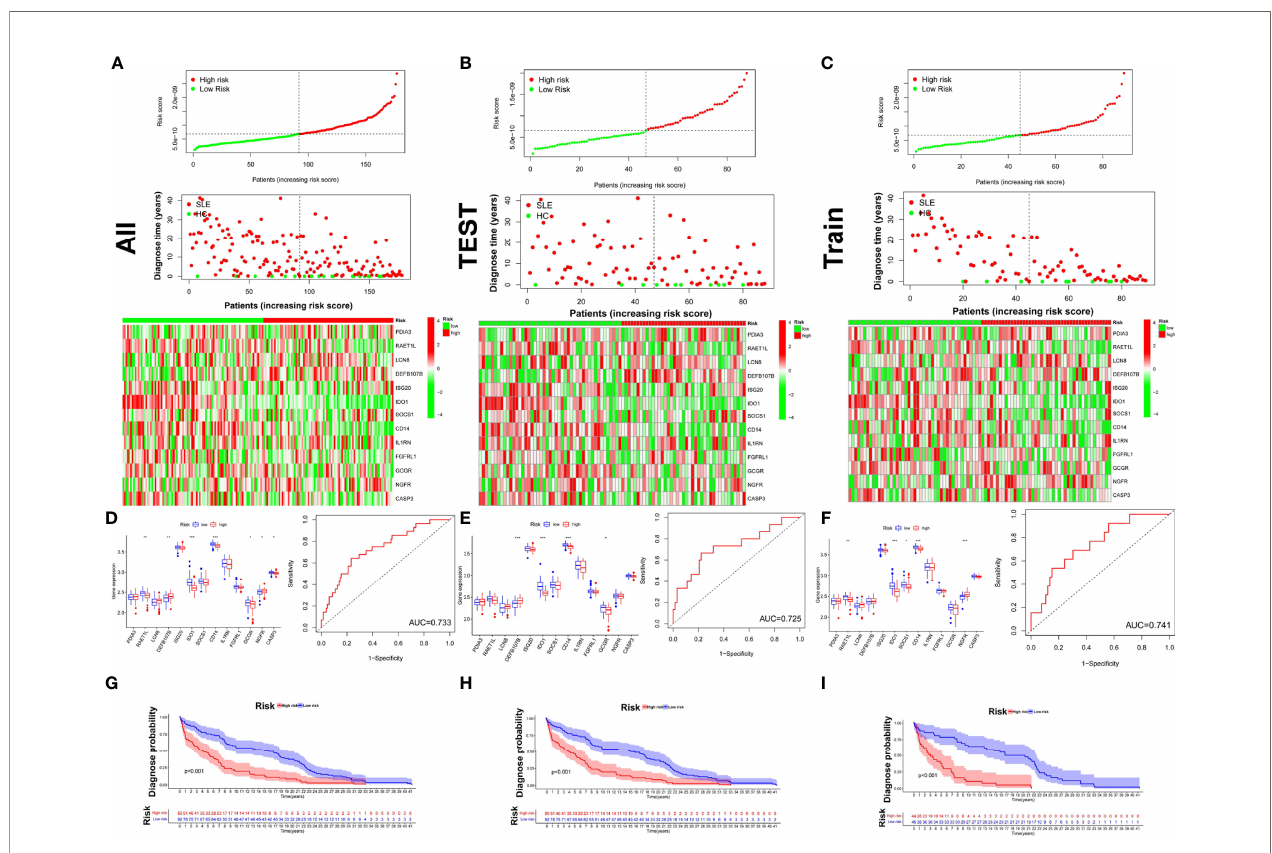
FIGURE 11 | Diagnostic and time-dependent risk score analysis for the immune gene signature in SLE. (A – C) The signature risk score distribution, status of samples in the high- and low-risk groups, and heatmaps of the expression pro fi les of members in the 13 immune – gene signature in three sets [all (A) , test (B) , training (C) ] of the GSE49454 dataset. (D – F) Boxplot of 13 diagnostic molecules between high- and low-risk patients and the ROC curve for diagnostic predictions in the three sets. (G-I) Kaplan – Meier curve between high- and low-risk patients. The validation sets using the test set and the entire set. *P < 0.05; **P < 0.01; ***p <